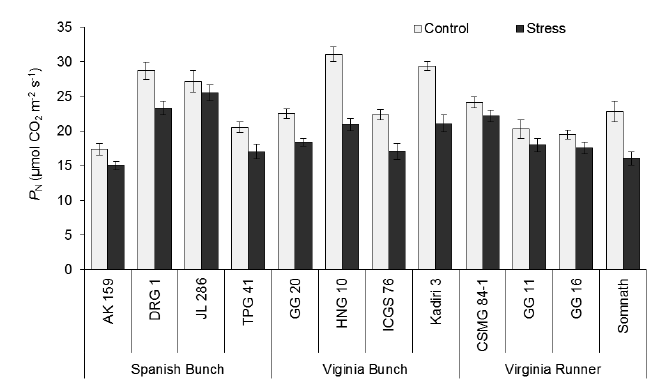
Fig. 2: Changes in net photosynthesis rate ( P N ) in groundnut leaves under water deficit